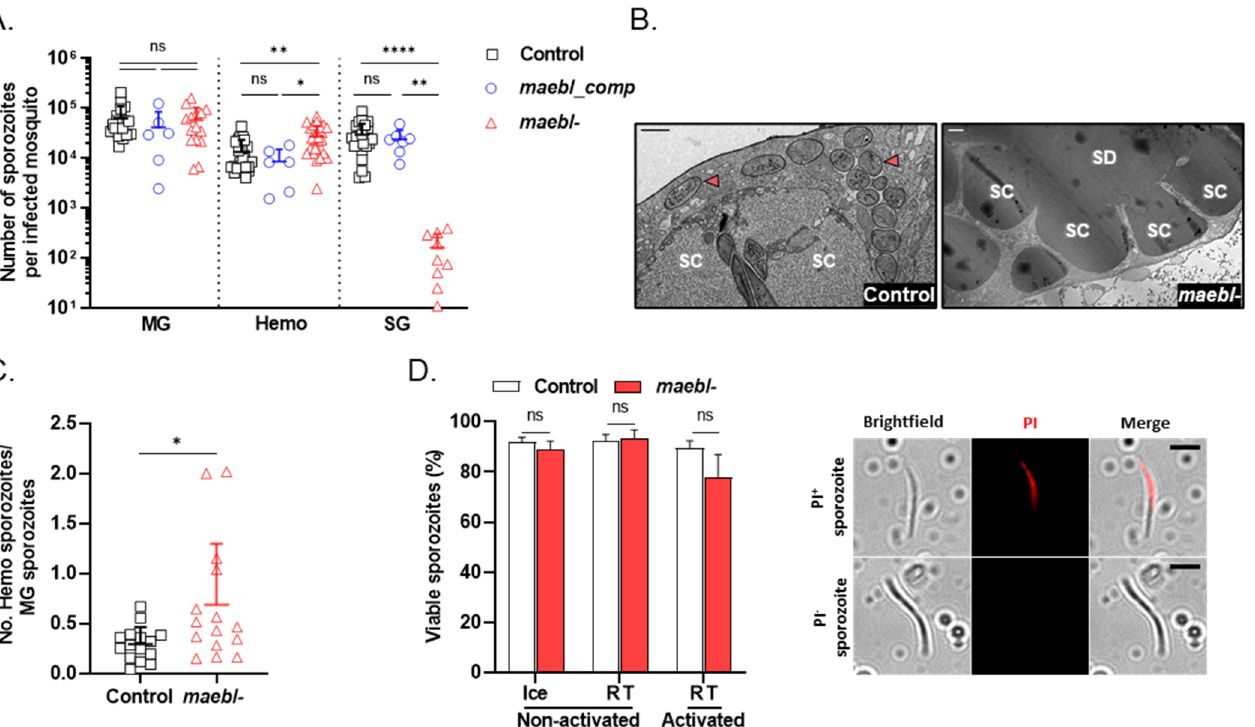
Figure 1. Development of maebl - and maebl_comp parasites in the mosquito. ( A ) Number of sporozoites in the midgut (MG), hemolymph (Hemo), and salivary glands (SG) of mosquitoes infected with Control, maebl_comp , or maebl - parasites, on days 18 to 26 post-infection. Symbols represent the counts in independent experiments and bars indicate the mean + SD. Statistical significance was determined using one-way ANOVA (Kruskal–Wallis test with Dunn’s multiple comparisons test). ( B ) Transmission electron micrographs of salivary glands of Control- or maebl - -infected mosquitoes, dissected on day 27 post-infection. SC, secretory cavity; SD, salivary duct; red arrows, sporozoites. Scale bar, 1 µ m ( left panel) or 2 µ m ( right panel). ( C ) Ratio of hemolymph (Hemo) to midgut (MG) sporozoites in Control- or maebl - infected mosquitoes, between days 18 and 21 post-infection.